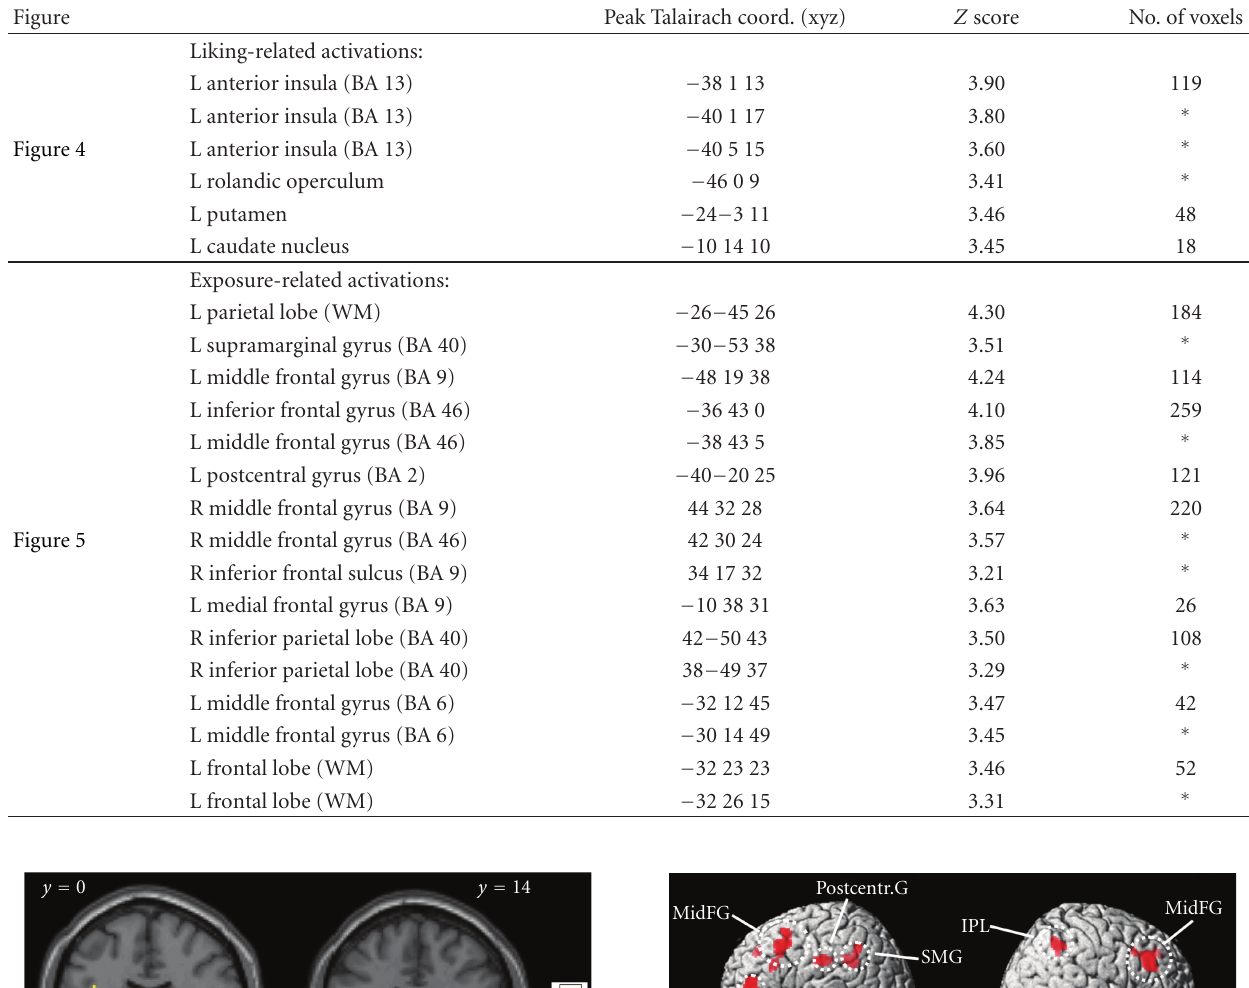
Table 2: Liking- and exposure-related brain activations. Overview of activations related to liking and to previous exposure when listening to melodies. Talairach coordinates for the peak activation sites, and their Z scores, plus the amount of voxels in each cluster are shown. Random e ff ects analysis; P < 0 . 001, uncorrected, only cluster sizes of more than 10 voxels included. WM: white matter; ∗ : areas of activation with an asterisk in the “No. of voxels” column were a part of the cluster reported immediately above it. Figure